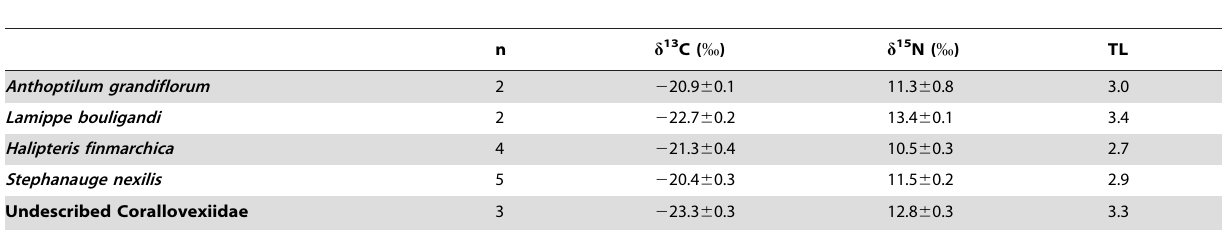
Table 5. Carbon and nitrogen stable isotope signatures ( d 13 C and d 15 N), and trophic level (TL) of Anthoptilum grandiflorum and Halipteris finmarchica and their dominant